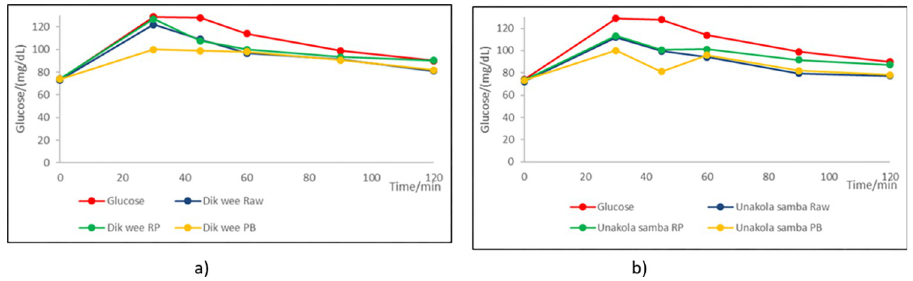
Fig 3. Average glucose response of differently processed a) Dik wee (red rice variety) over standard glucose b) Unakola samba (white rice variety) over standard glucose (RP-raw polished; PB-